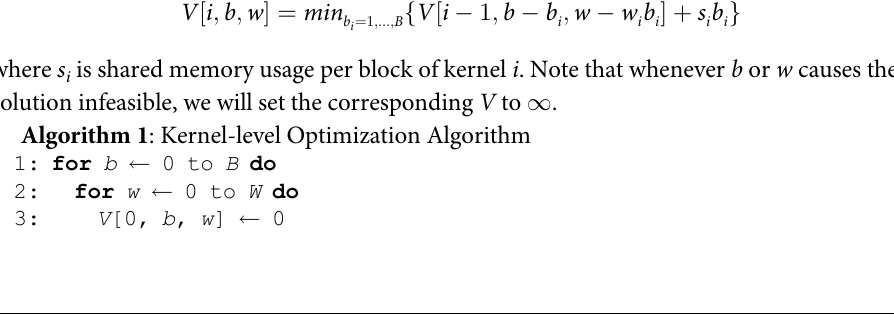
Algorithm 1 : Kernel-level Optimization